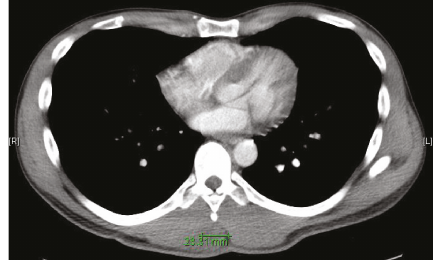
Figure 2: Mass noted on CT imaging.